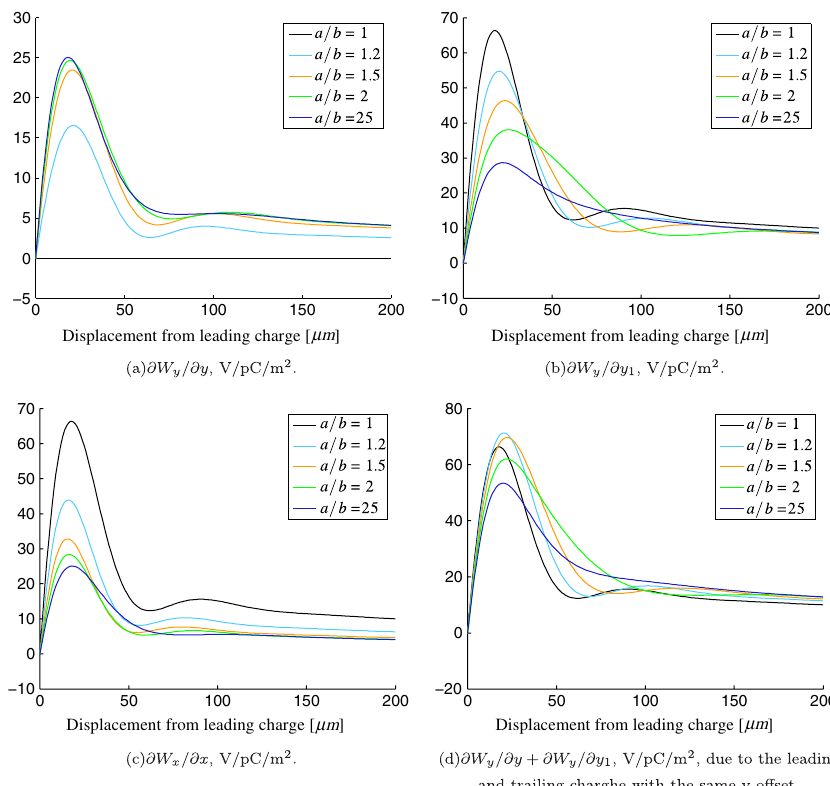
FIG. 6. (Color) Transverse wake functions in the case where both charges are close to the vacuum chamber axis. The vacuum chamber has short half-axis of length b (cid:4) 1 cm , the metal wall is characterized by a conductivity (cid:1) (cid:4) 5 : 3 (cid:9) 10 7 Sm (cid:1) 1 , and the DC conductivity model has been used.